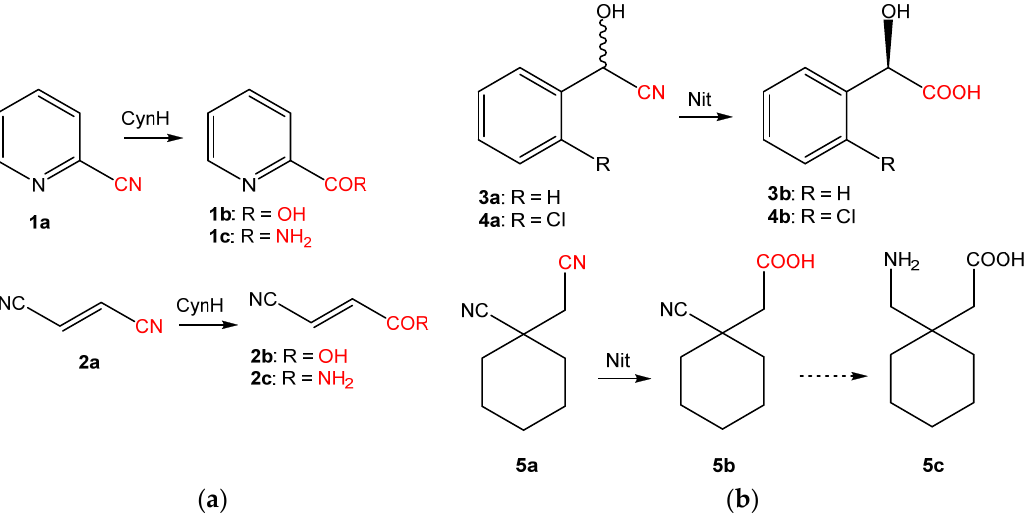
Figure 2. Examples of nitrile conversions by ( a ) cyanide hydratases (CynHs) and ( b ) nitrilases (Nits). CynHs produce carboxylic acids and/or amides from 2-cyanopyridine ( 1a ) and fumaronitrile ( 2a ). The acid ( 1b , 2b )/amide ( 1c , 2c ) ratio depends on enzyme origin [15]. Some bacterial Nits produce enantiopure R -mandelic acids 3b and 4b from ( R,S )-mandelonitriles 3a and 4a [10,11], or 1-cyano- cyclohexaneacetic acid 5b, the precursor of gabapentin ( 5c ), from the corresponding dinitrile 5a [12].